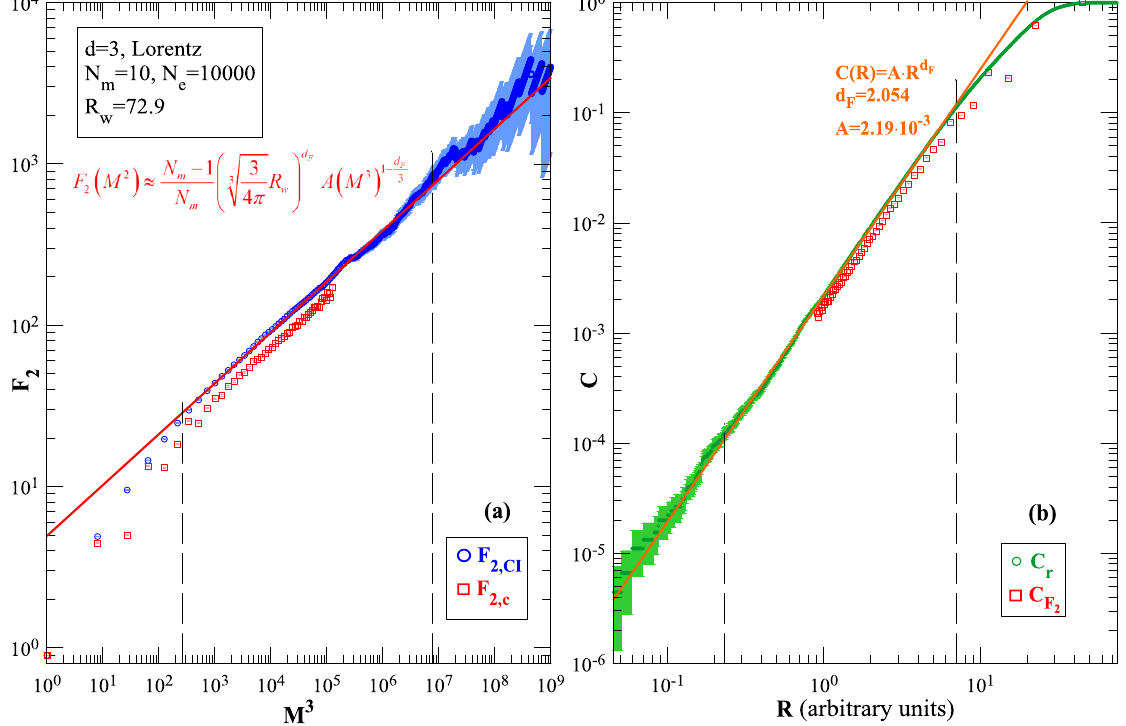
Fig. 11 Analysis of a Lorentz data set of N e = 10 , 000 events and multiplicity N m = 10 in an embedding space of d = 3